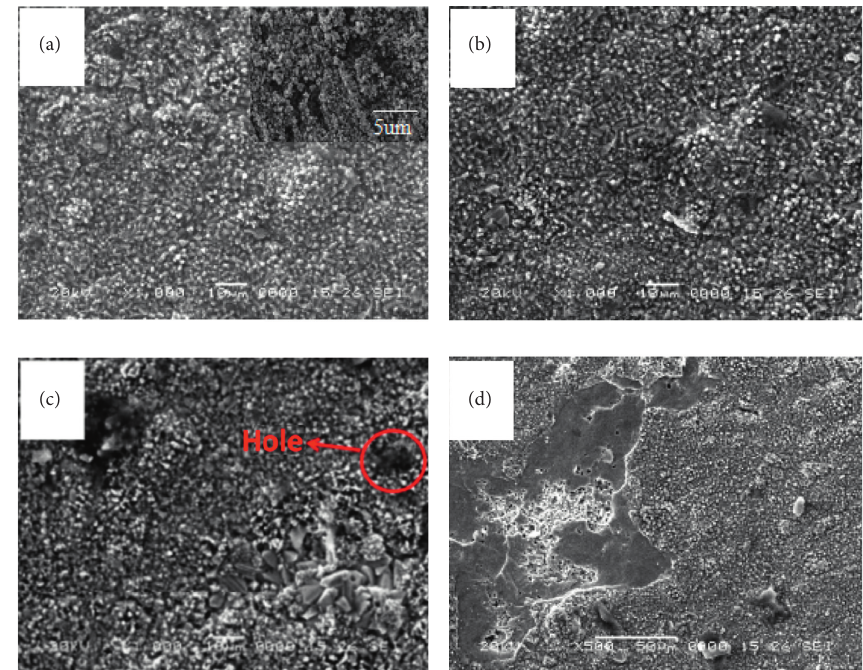
Figure 3: Surface morphology of substrate oxidized at 1050 ° C for 20h, 40h, 60h, and 100h. (a) Oxidizing the 20h coating. (b) Oxidizing the 40h coating. (c) Oxidizing the 60h coating. (d) Oxidizing the 100h coating.